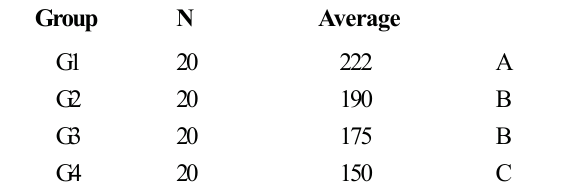
Comparison of groups Tukey test for rupture pressure Averages with the same letter are not statistically different